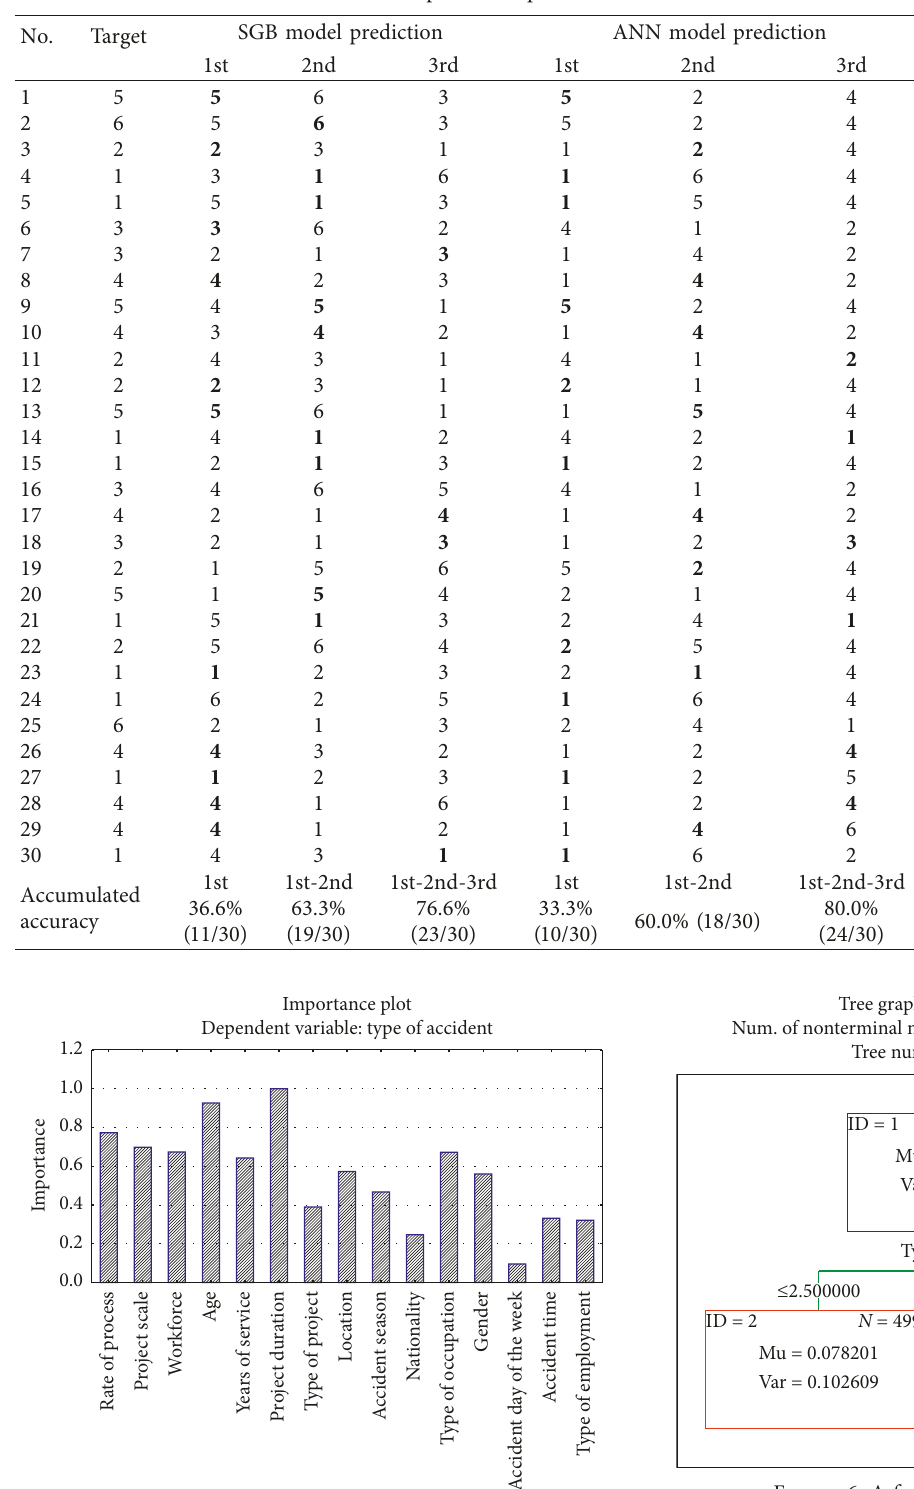
Table 3: Comparison of prediction results of SGB, ANN, and DT models.